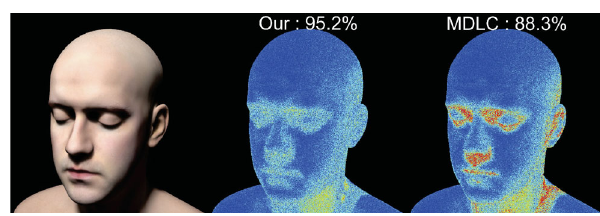
Fig. 8 Human head scene (subsurface scattering with anti-aliasing (8 spp)).